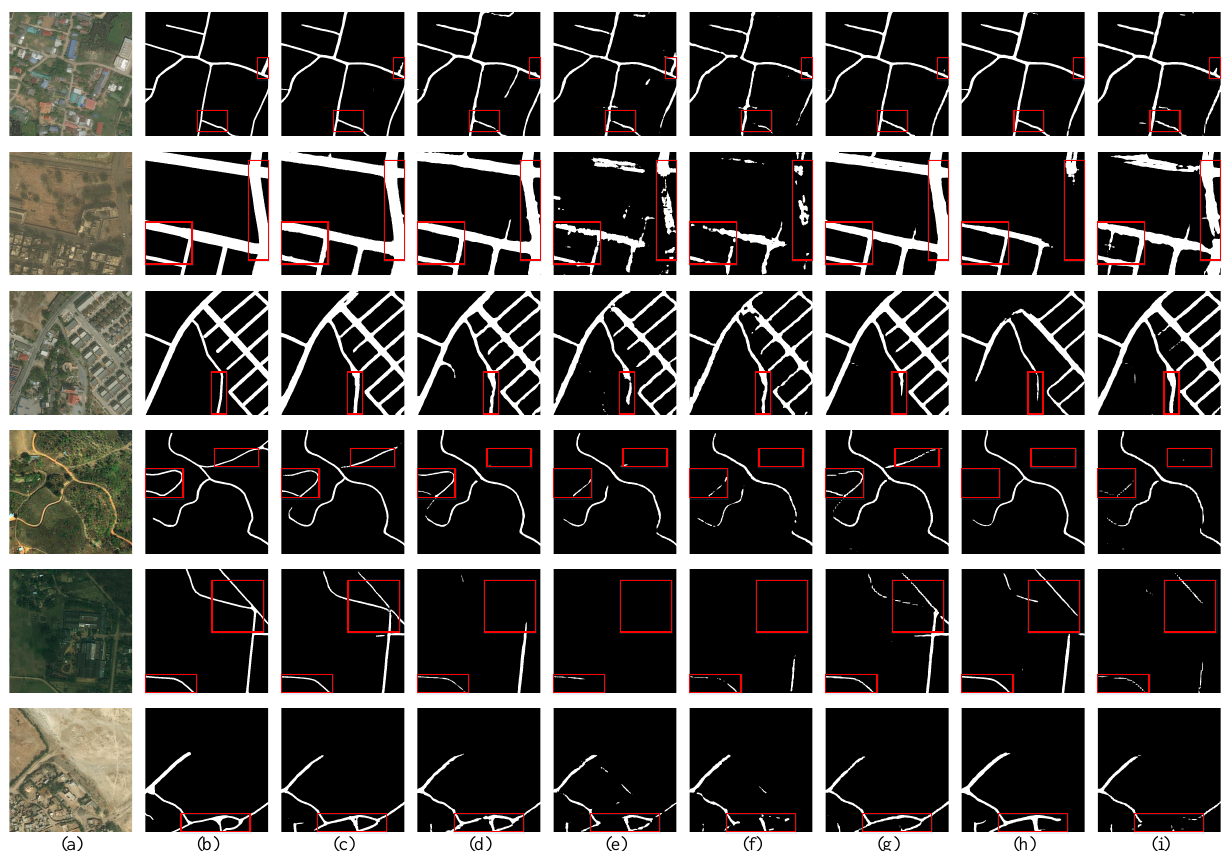
Figure 6. Visualization of segmentation results generated by different methods on the DeepGlobe dataset. ( a ) Original image. ( b ) Ground truth. ( c ) CSANet. ( d ) Deeplabv3. ( e ) UNet. ( f ) ENet. ( g ) CFPNet. ( h ) SegNet. ( i ) PSPNet.